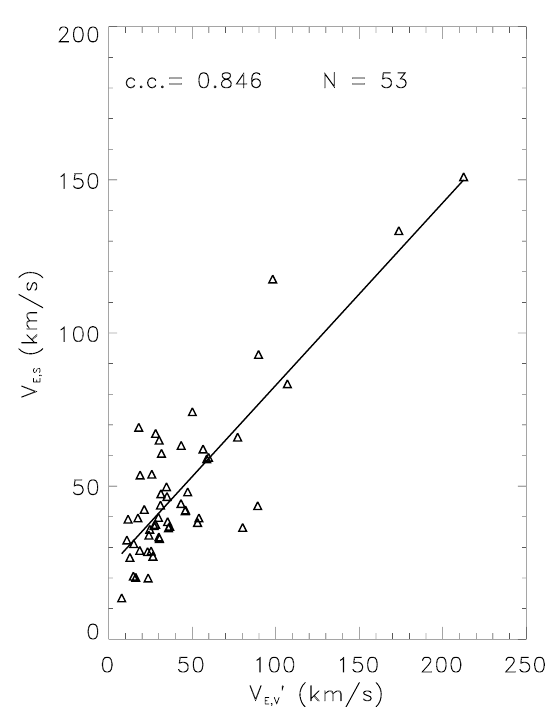
Fig. 6. A scatter diagram of V E,S vs. V 0